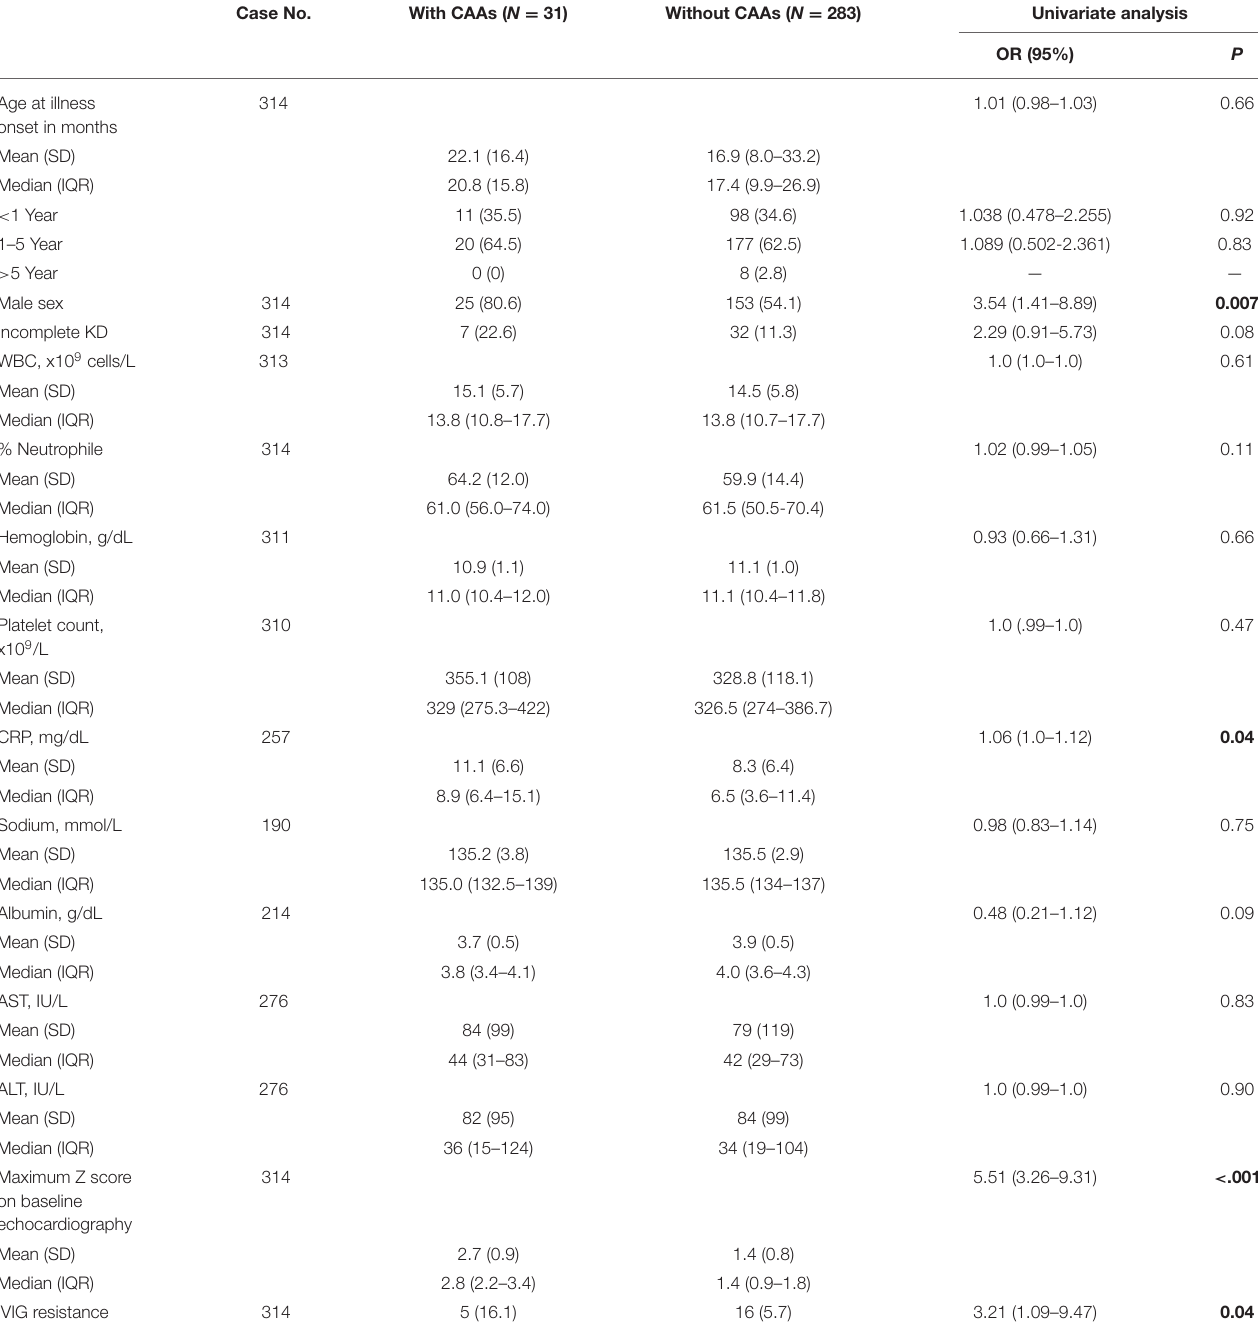
TABLE 1 | Comparisons between patients with and without coronary artery aneurysms at 11 to 60 days of illness. Case No. With CAAs ( N =